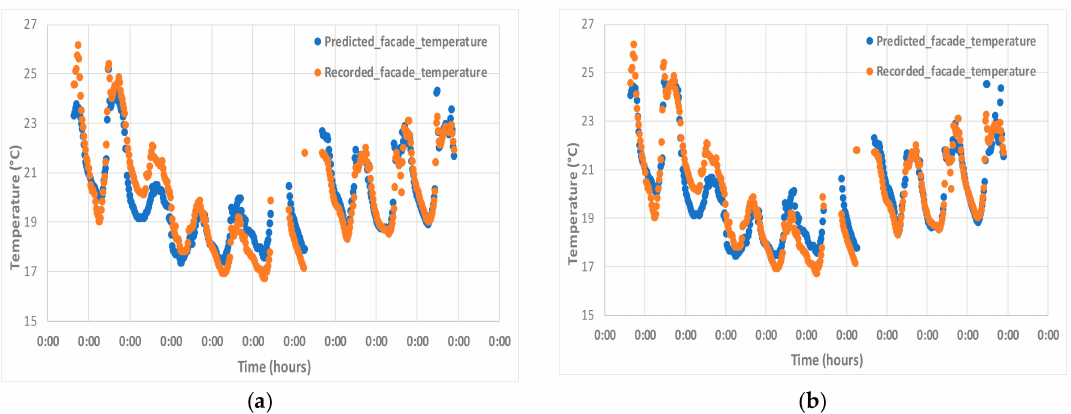
Figure 5. Recorded and predicted facade temperature variation in the time domain: ( a ) prediction for 0.5 h; and ( b ) prediction for 1 h.